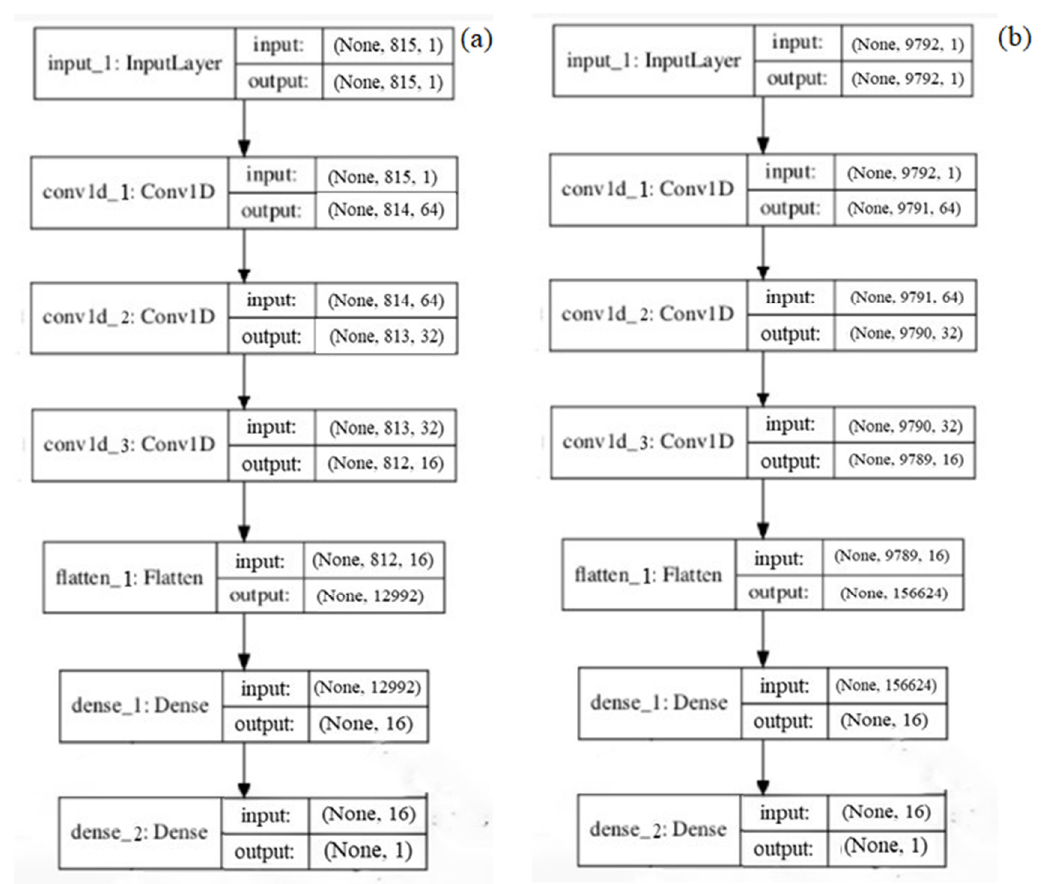
Figure 10. ( a ) The proposed CNN architecture for single-lead, ( b ) the proposed CNN architecture for multi-lead.